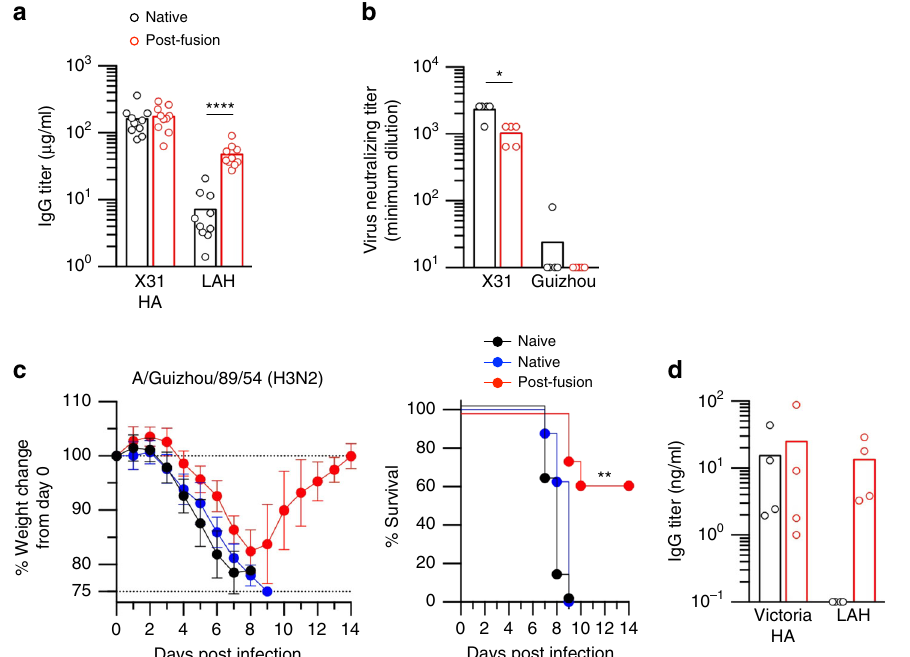
Fig. 6 Post-fusion HA antigen elicits protective serum antibodies against drifted virus. a Native and post-fusion HA antigens were i.p. injected twice at 4- week intervals. Serum were collected at day 14 after boosting, and subjected to ELISA that detects X31 HA- and LAH-binding IgG. Each circle represents the result from an individual mouse. The combined data from two independent experiments are shown. b Immune sera were subjected to a microneutralization assay using H3N2 virus strains (X31 and Guizhou) as challenging viruses. Each circle represents the result from pooled sera ( n = 5). c The protective function of the immune sera (blue, native; red, post-fusion HA) and non-immune sera (black, naive) as control were i.p. transferred into the mice, which were then challenged by lethal dose (5 × LD50) of heterogeneous H3N2 (Guizhou) infection. The combined data from two independent experiments ( n = 8 per group) are shown. Values represent mean ± s.d. d NOJ mice were reconstituted with human PBMCs and then boosted with native and post-fusion HA antigens (Victoria strain). At day 10 post-vaccination, sera were collected and analyzed for anti-HA and anti-LAH human IgG titers by ELISA. Each circle represents the result from an individual mouse harboring PBMC of single donor. The P -values were determined with a two-tailed Mann – Whitney test ( a , b ) and log-rank test ( c ). * P < 0.05; ** P < 0.01; **** P < 0.0001. Source data are provided as a Source Data fi